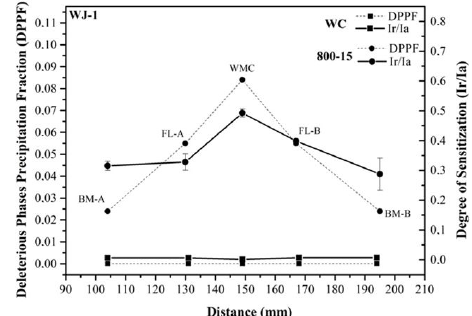
Figure 11. DOS (Ir/Ia ratio) and deleterious phases volume fraction as a function of the analyzed region for the WJ1-15